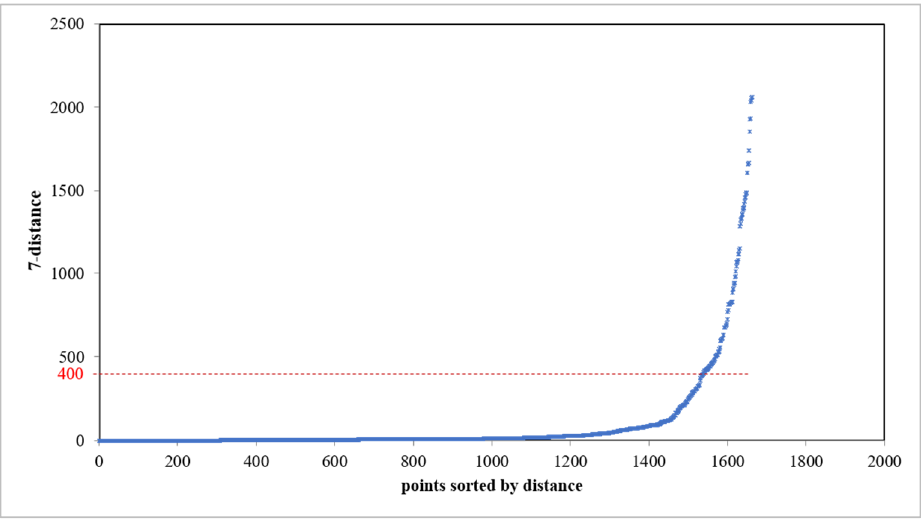
Figure 6. The illustration of the 7-distance plot.